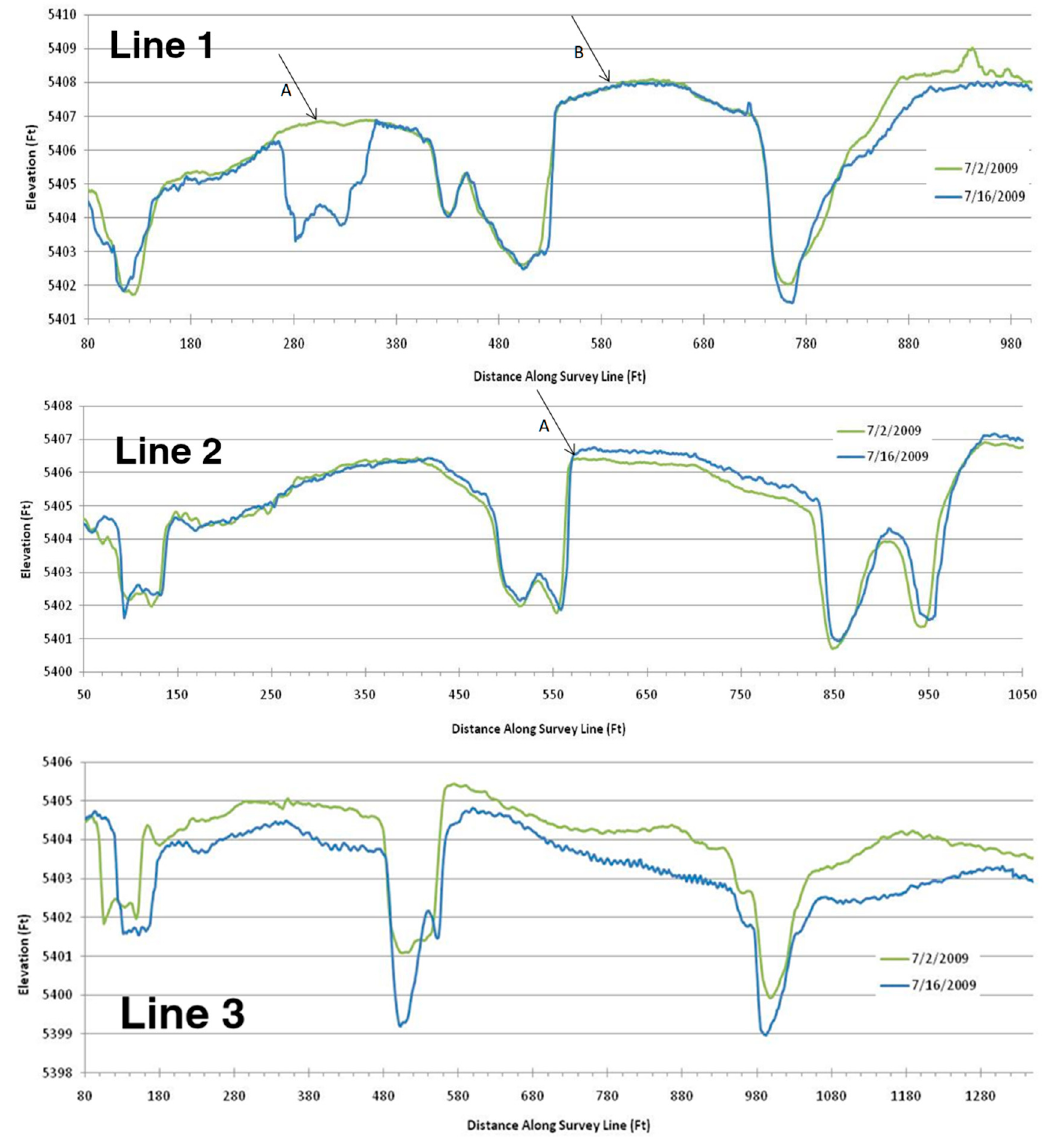
Figure 7. Survey results for Lines 1–3. These lines were only surveyed twice and reservoir drawdown made these areas unreachable because of how shallow the water was. The results show obvious errors resulting from various survey issues.